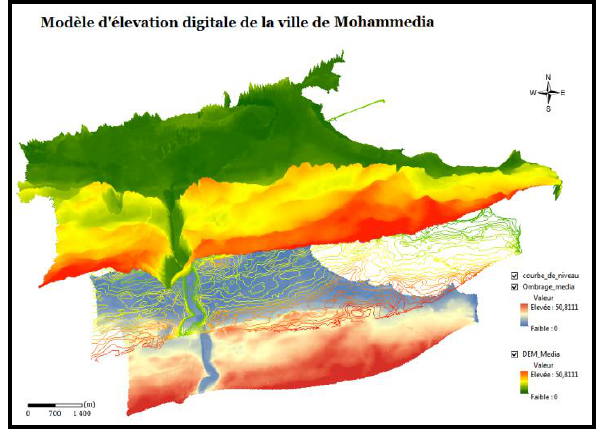
Figure 1. Digital elevation model of the area of the study - Mohammedia -